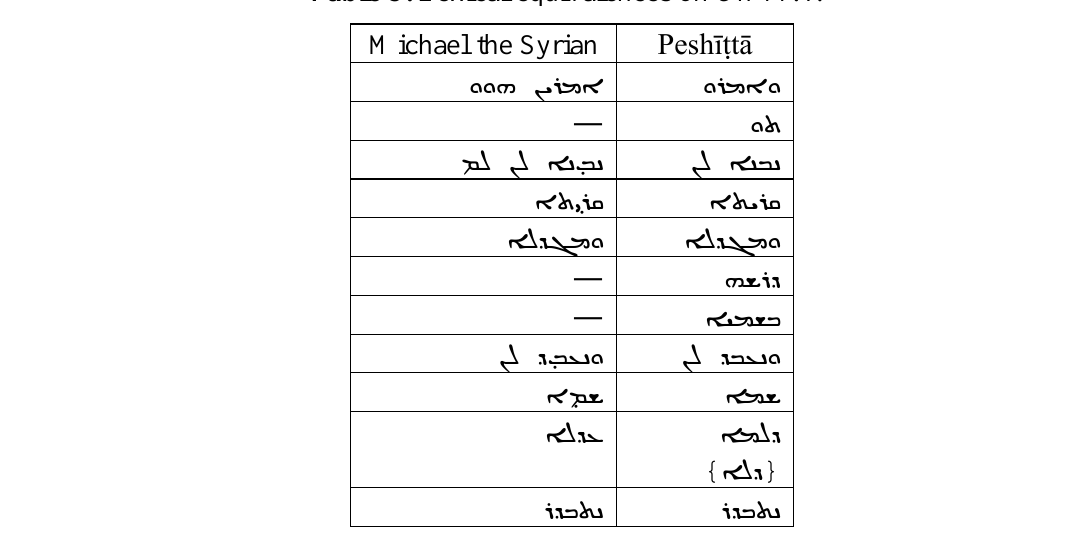
Table 3. Lexical equivalences on Gn 11:4.